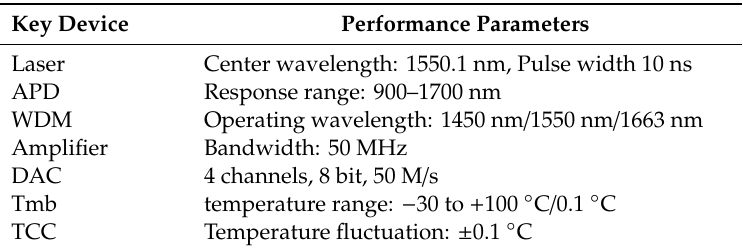
Figure 4. Experimental setup of Raman distributed temperature sensor (RDTS) systems, Tmb: thermostatic bath, WDM: wavelength division multiplexer, APD: avalanche photodiode, DAC: data acquisition card, TCC: temperature control chamber. Table 1. Parameters of each device in the experiment.